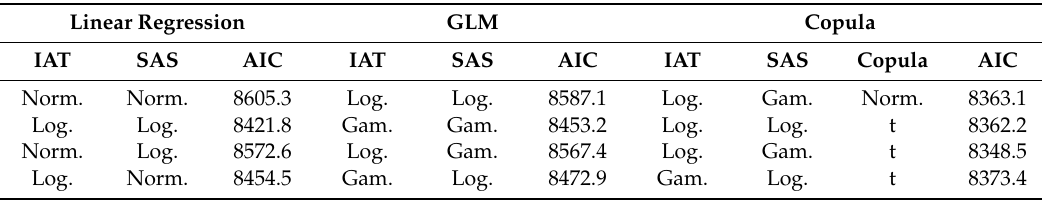
Table 4. Model comparison results.